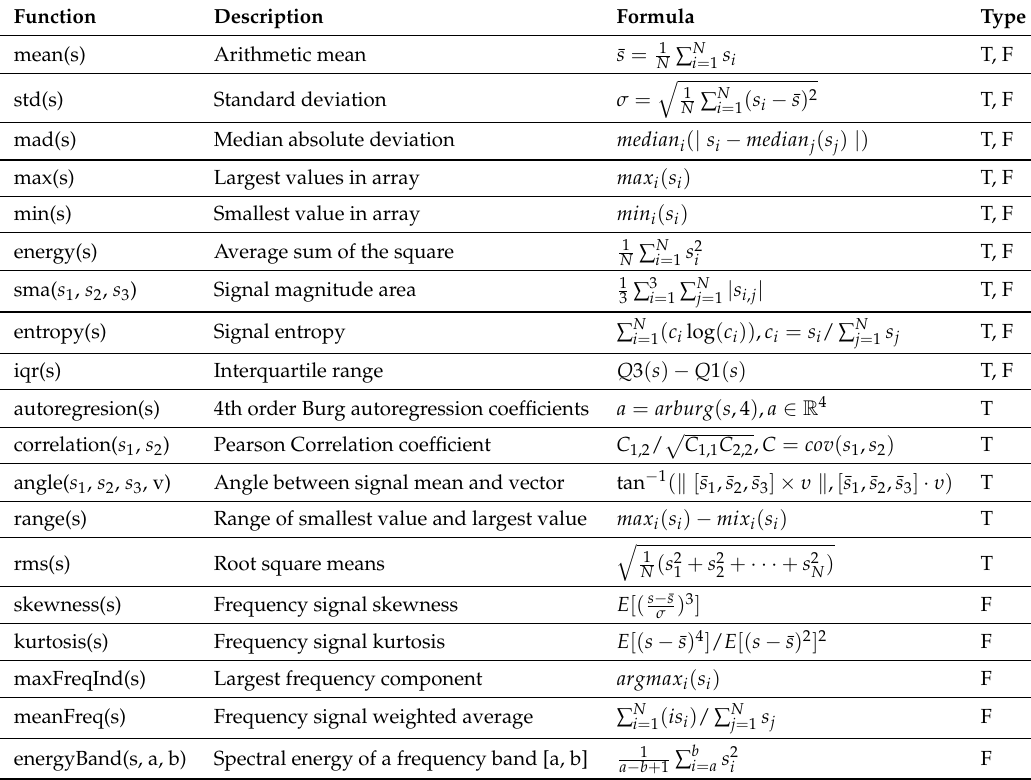
Table 2. Function list for feature